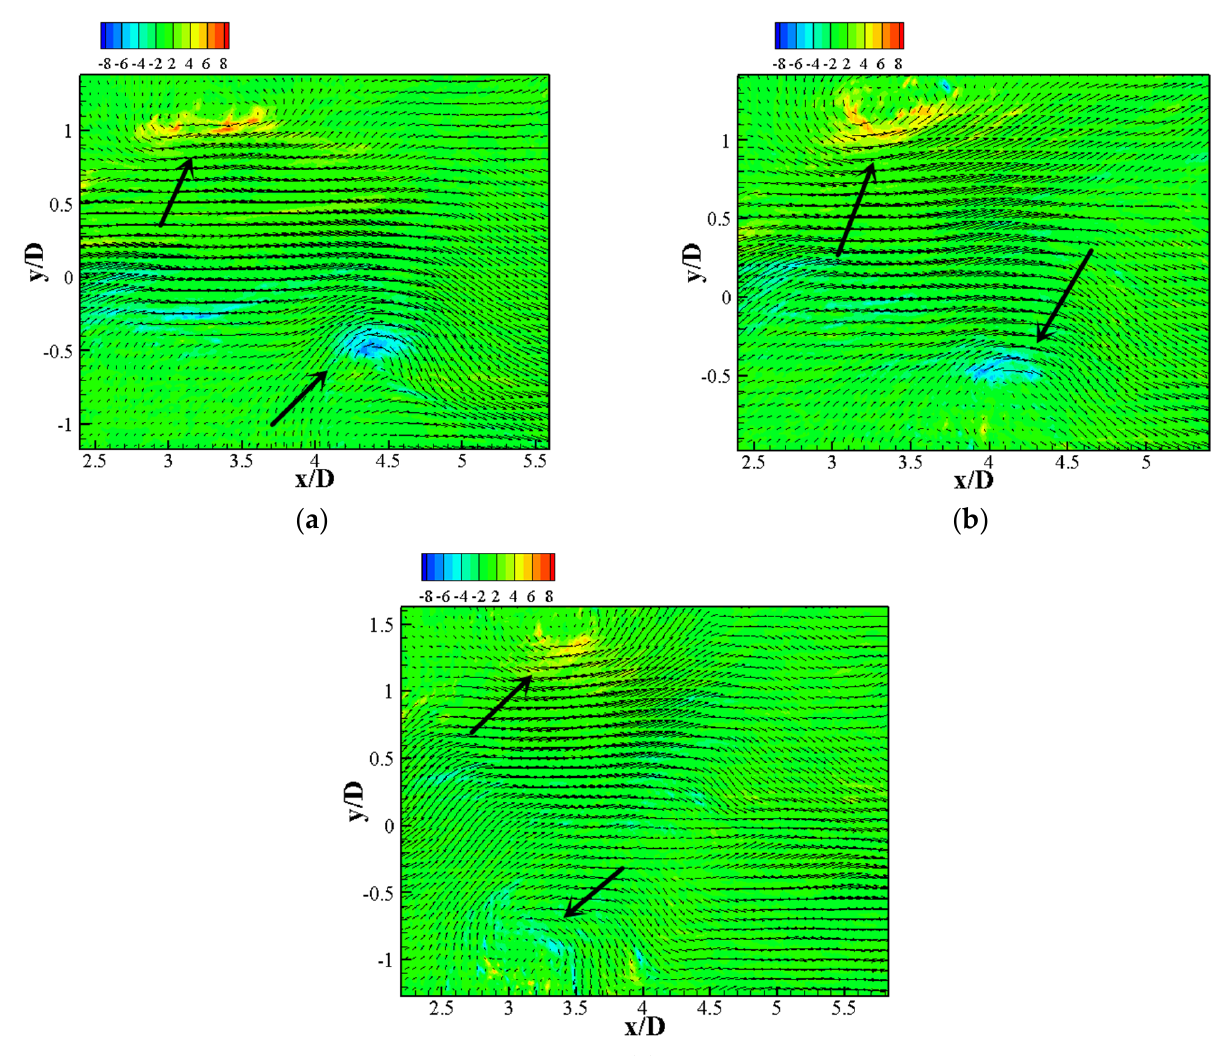
Figure 15. Spanwise vorticity in the forced plane in the downstream field under different amplitudes, normalized by U j / D . ( a ) MFR = 0.67%, ( b ) MFR = 1%, ( c ) MFR = 1.5%. The behavior of the azimuthal vortex can also be indicated by the PSD of the velocity fluctuation in the shear layer. The instantaneous velocity was collected at the lip line of the forced plane at different streamwise positions ( y / D = 0.5, x / D = 2, 4). In Figure 16a, the peak value at forcing frequency f e implies that the vortex strength increases with increasing amplitude. This is consistent with the observations in Figure 14. When the spanwise structure evolves into a full ring, two rings go through the shear layer in a cycle; thus, the peak at 2 f e emerges. At x / D = 2, this value is distinct at MFR = 1.5%, while it is hardly discernible at MFR = 0.67%. This result proves the difference in azimuthal growth rate of the spanwise structure that was observed in Figure 13. In the downstream, the peak values at MFR = 1% become the largest, which indicates that the coherence of the vortex ring is impaired at higher